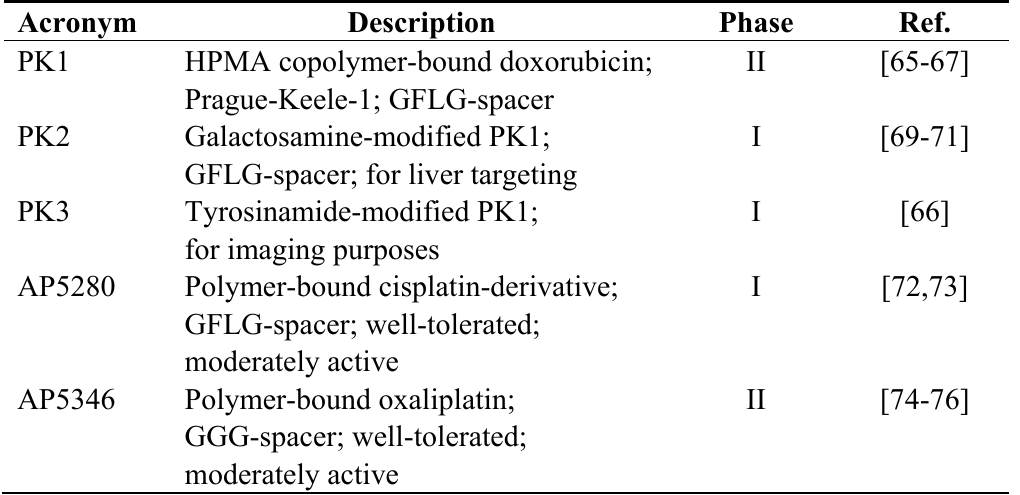
Table 4. Selected List of N-(2-hydroxypropyl) Methacrylamide HPMA copolymer based formulations in various phases of clinical trials (Adapted from